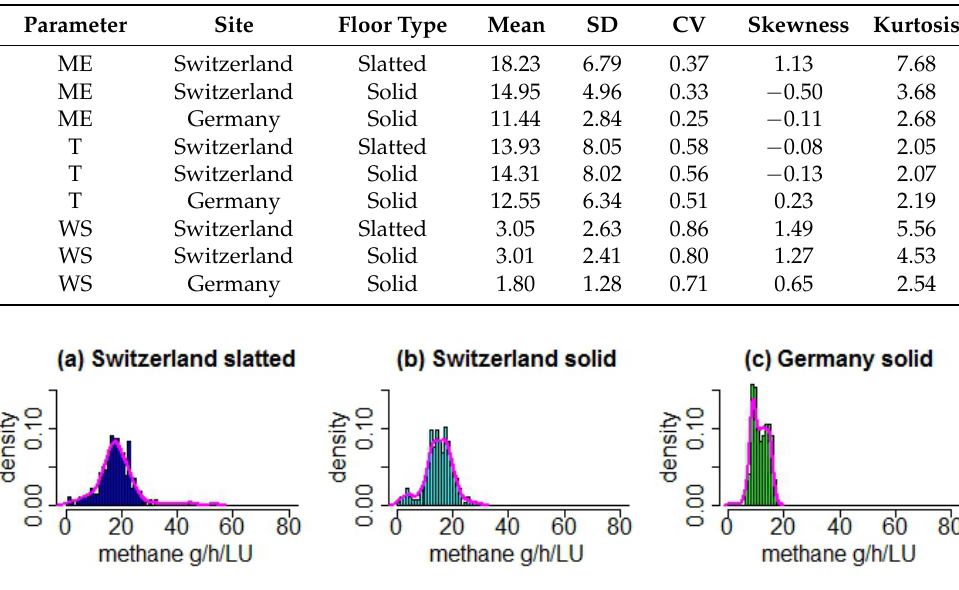
Figure 1. Histograms showing the density distributions of CH 4 emission per livestock unit (LU) in the three datasets: ( a ) compartment with slatted floor at Swiss farm, ( b ) compartment with solid floor at Swiss farm, and ( c ) building with solid floor at German farm. Breaks were set from 0 to 100 in steps of 1 for the